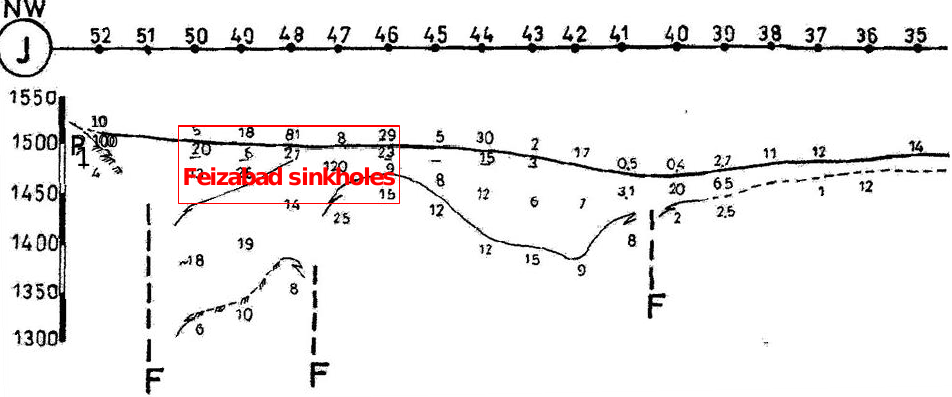
Figure 11. Cross section of the J profile—Feizabad